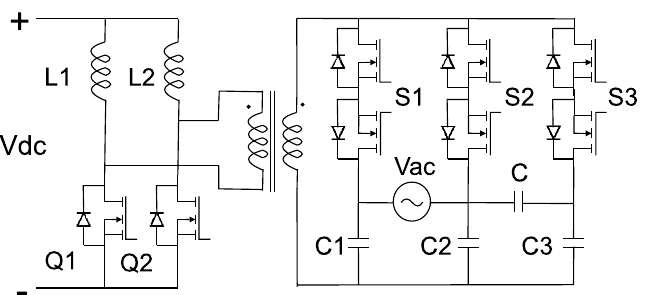
Figure 9. Series interfacing of active power APDC.